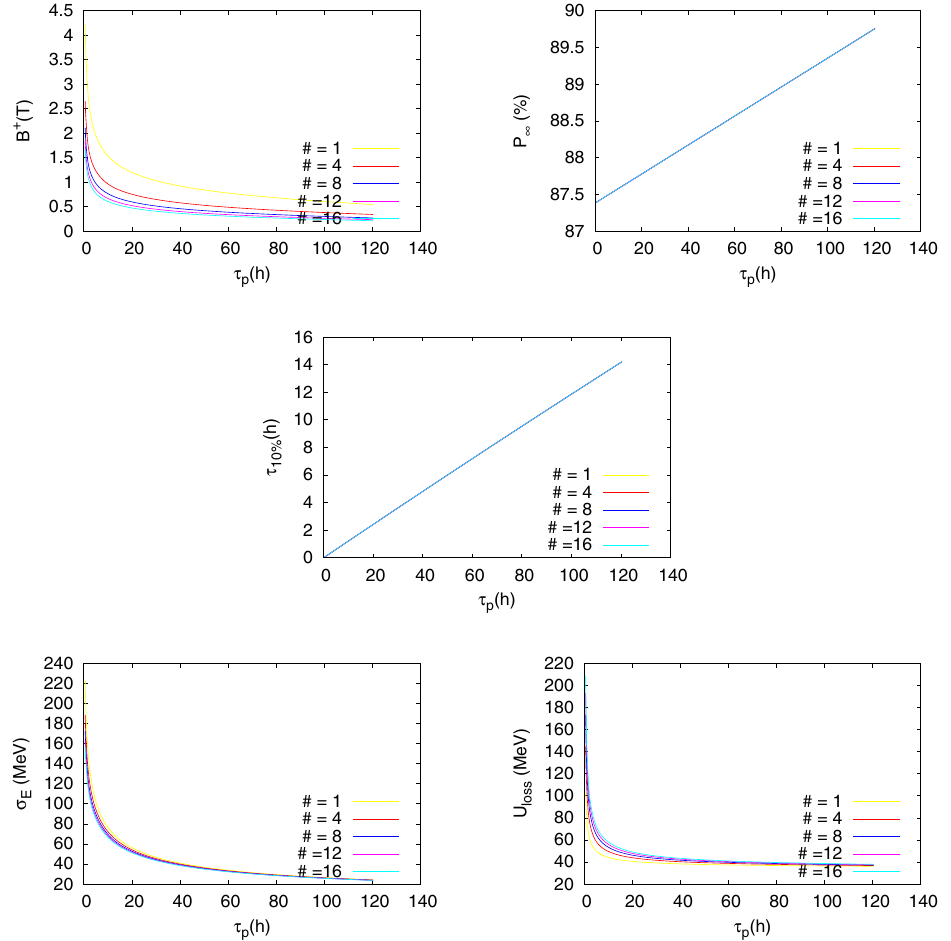
FIG. 3. Parameter values vs. polarization time for different numbers of wigglers units at 45 GeV with N ¼ 6 and L þ ¼ 1 . 3 m. Top left: B þ . Top right: Asymptotic polarization. Center: τ 10% . Bottom left: Energy spread. Bottom right: Energy lost per turn. B. 60 ° = 60 ° FODO — 80 GeV beam energy The polarization achieved for the same machine with a less aggressive closed orbit correction using a limited At 80 GeV wigglers are not needed. However the larger number of correctors followed by δ ˆ n 0 correction is shown synchrotron radiation emitted by the particles increases spin in Fig. 8. The 110 vertical correctors for the closed orbit diffusion and energy spread (54 MeV, comparable to the correction are selected through the well-known MICADO 45 GeV case with wigglers). In addition the same quadrupole algorithm. displacement distribution will produce a larger δ ˆ n 0 .